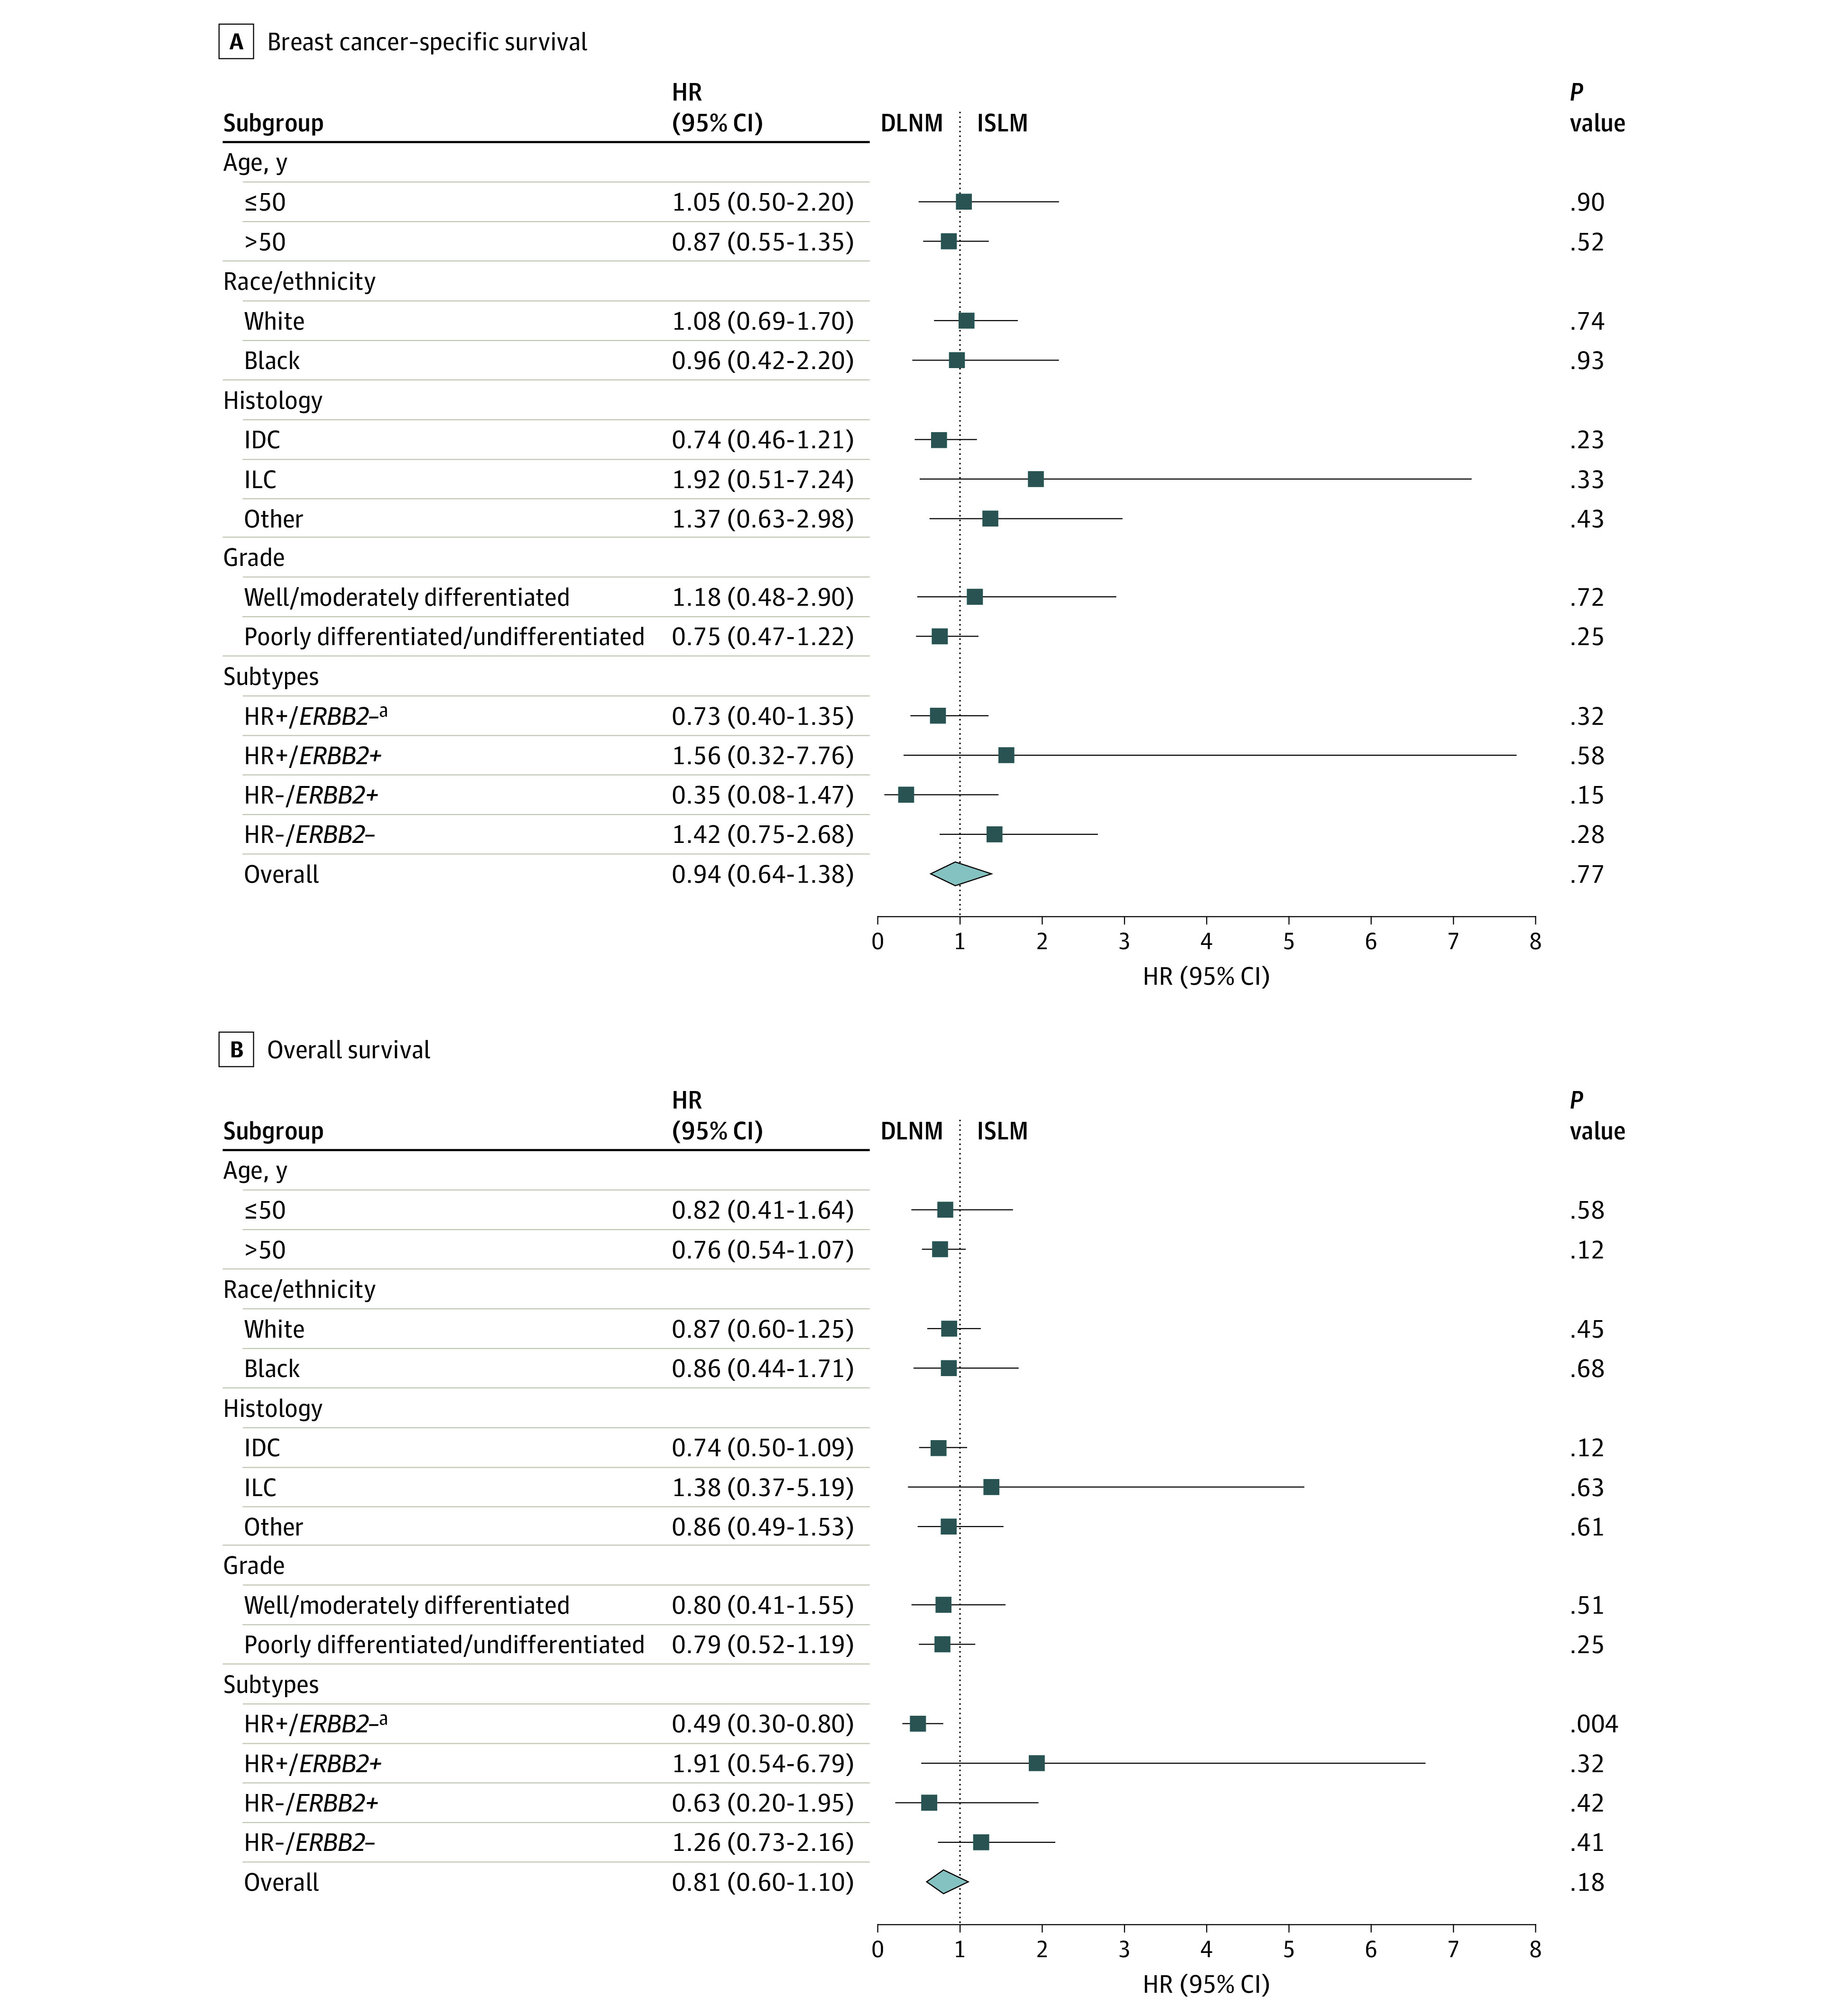
Subgroup Analysis of Breast Cancer–Specific Survival and Overall Survival in Patients With Breast Cancer With Distant Lymph Node Metastases (DLNM) vs Ipsilateral Supraclavicular Lymph Node Metastases (ISLM)Breast cancer–specific survival (A) and overall survival (B) over time. HR indicates hazard ratio; HR−, hormone-receptor negative; HR+, hormone-receptor positive; IDC, invasive ductal carcinoma; ILC, invasive lobular carcinoma.aERBB2 (formerly HER2 or HER2/neu).